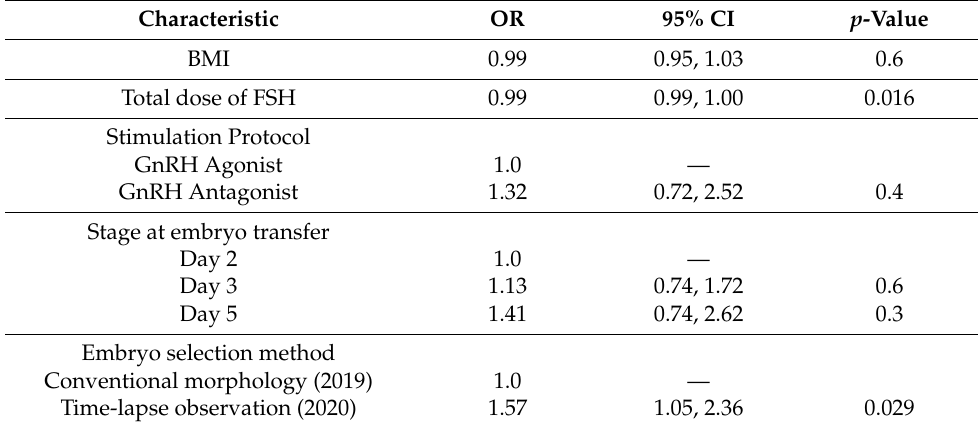
Table 5. Likelihood of clinical pregnancy presented as odds ratios (95% confidence